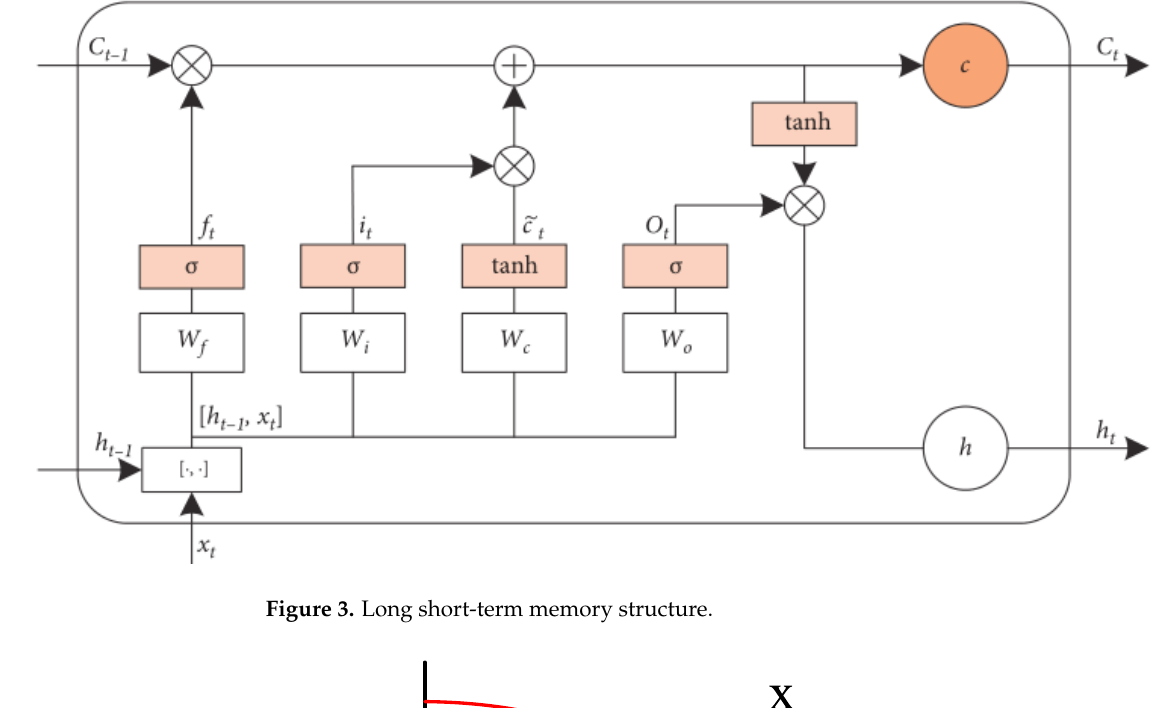
Figure 3. Long short-term memory structure.